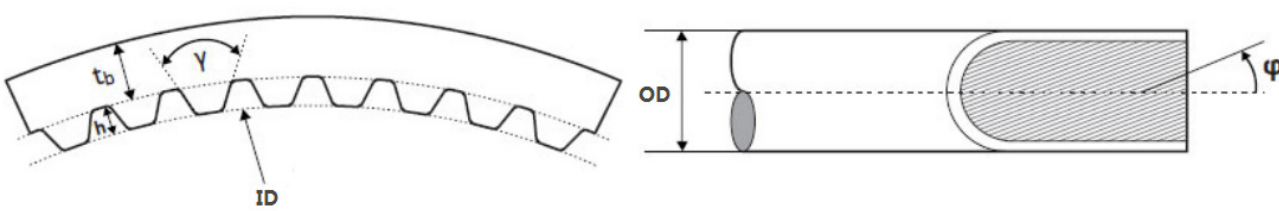
Figure 3. Geometric specification of a tested microfin tube.